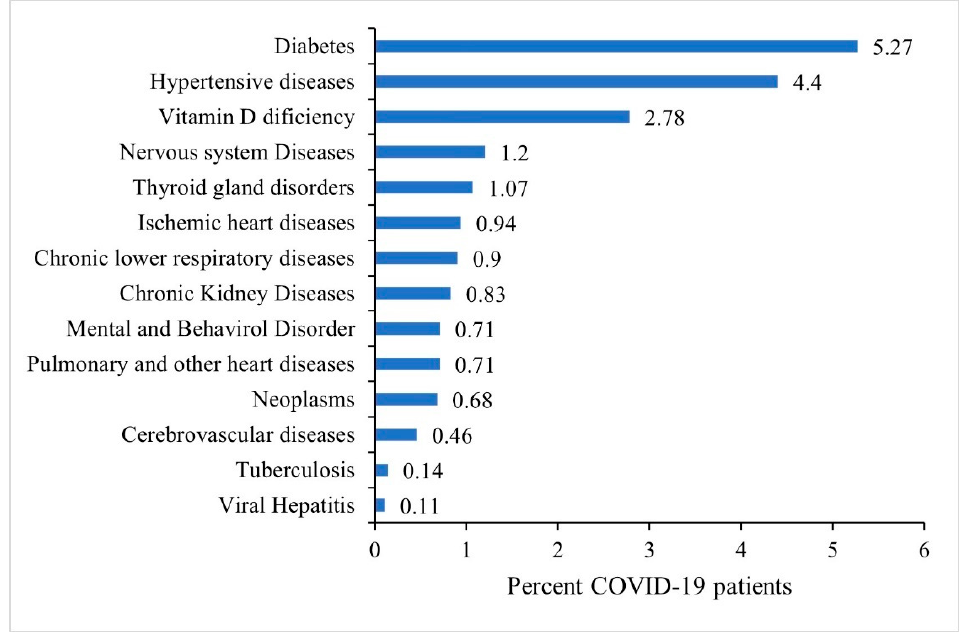
Figure 2. Demographic characteristics of COVID-19 patients admitted to ICU. The most prevalent pre-existing comorbidities among COVID-19 patients were dia- betes (5.27%) and hypertensive disorders (4.40%) followed by vitamin-D deficiency (2.78%), nervous system diseases (1.2%) and thyroid gland disorders (1.07%). Less than 1% of patients had other co-morbidities as shown in Figure 3.